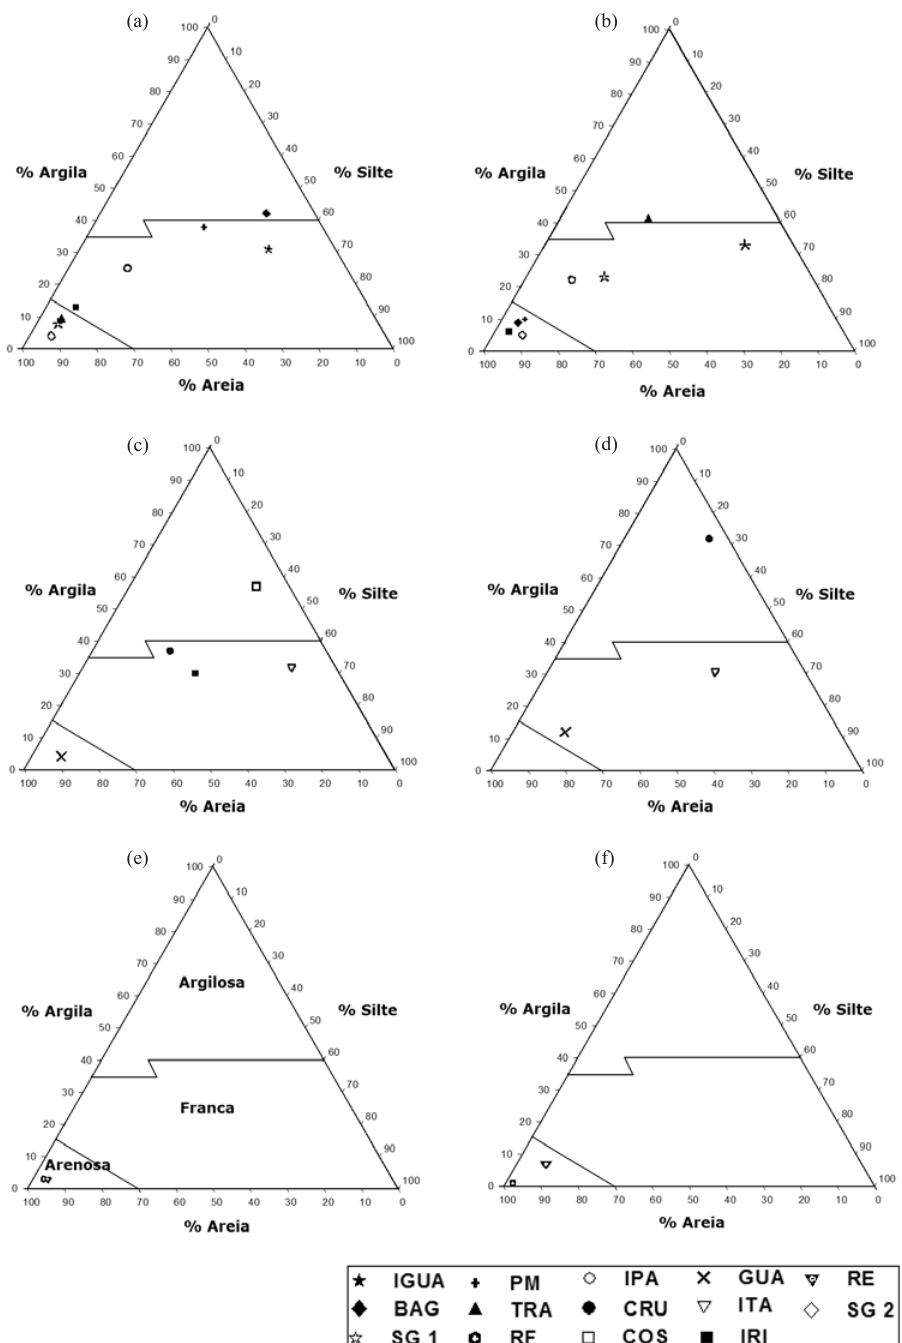
Figura 2. Classes texturais dos solos de manguezais estudados do litoral paulista: (a) Litoral Sul (0–20 cm); (b) Litoral Sul (60–80 cm); (c) Baixada Santista (0–20 cm); (d) Baixada Santista (60–80 cm); (e) Litoral Norte (0–20 cm); e (f) Litoral Norte (60–80